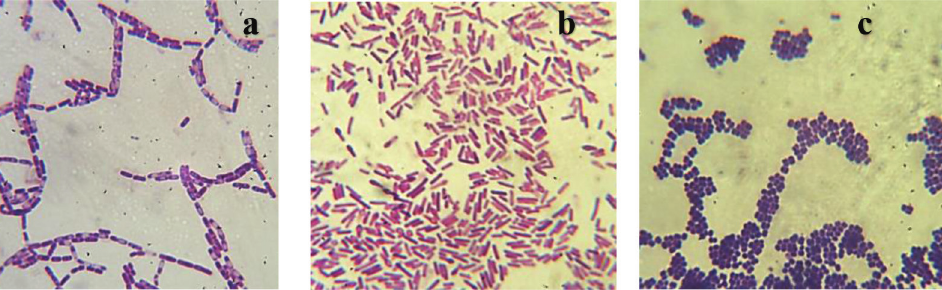
Figure 1: Gram staining micrograph of (a) Bacillus subtilis shows gram-positive bacilli in chains. (b) Pseudomonas aeruginosa shows gram-negative bacilli. (c) Rhodococcus shows gram-positive cocci.